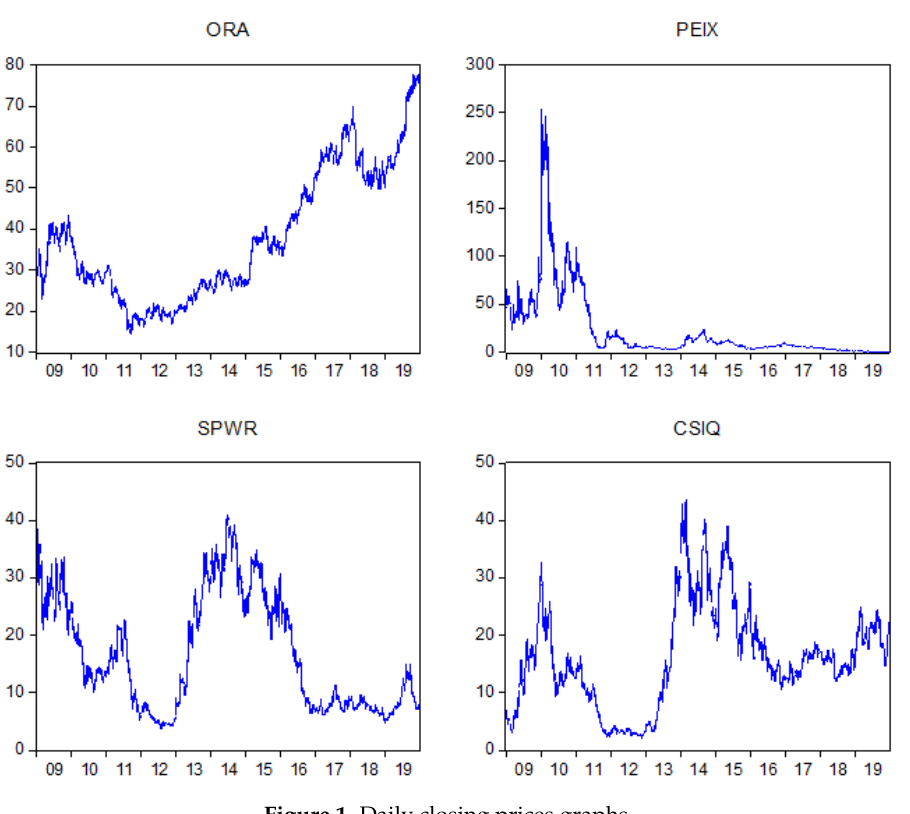
Figure 1. Daily closing prices graphs. Table 2. Descriptive